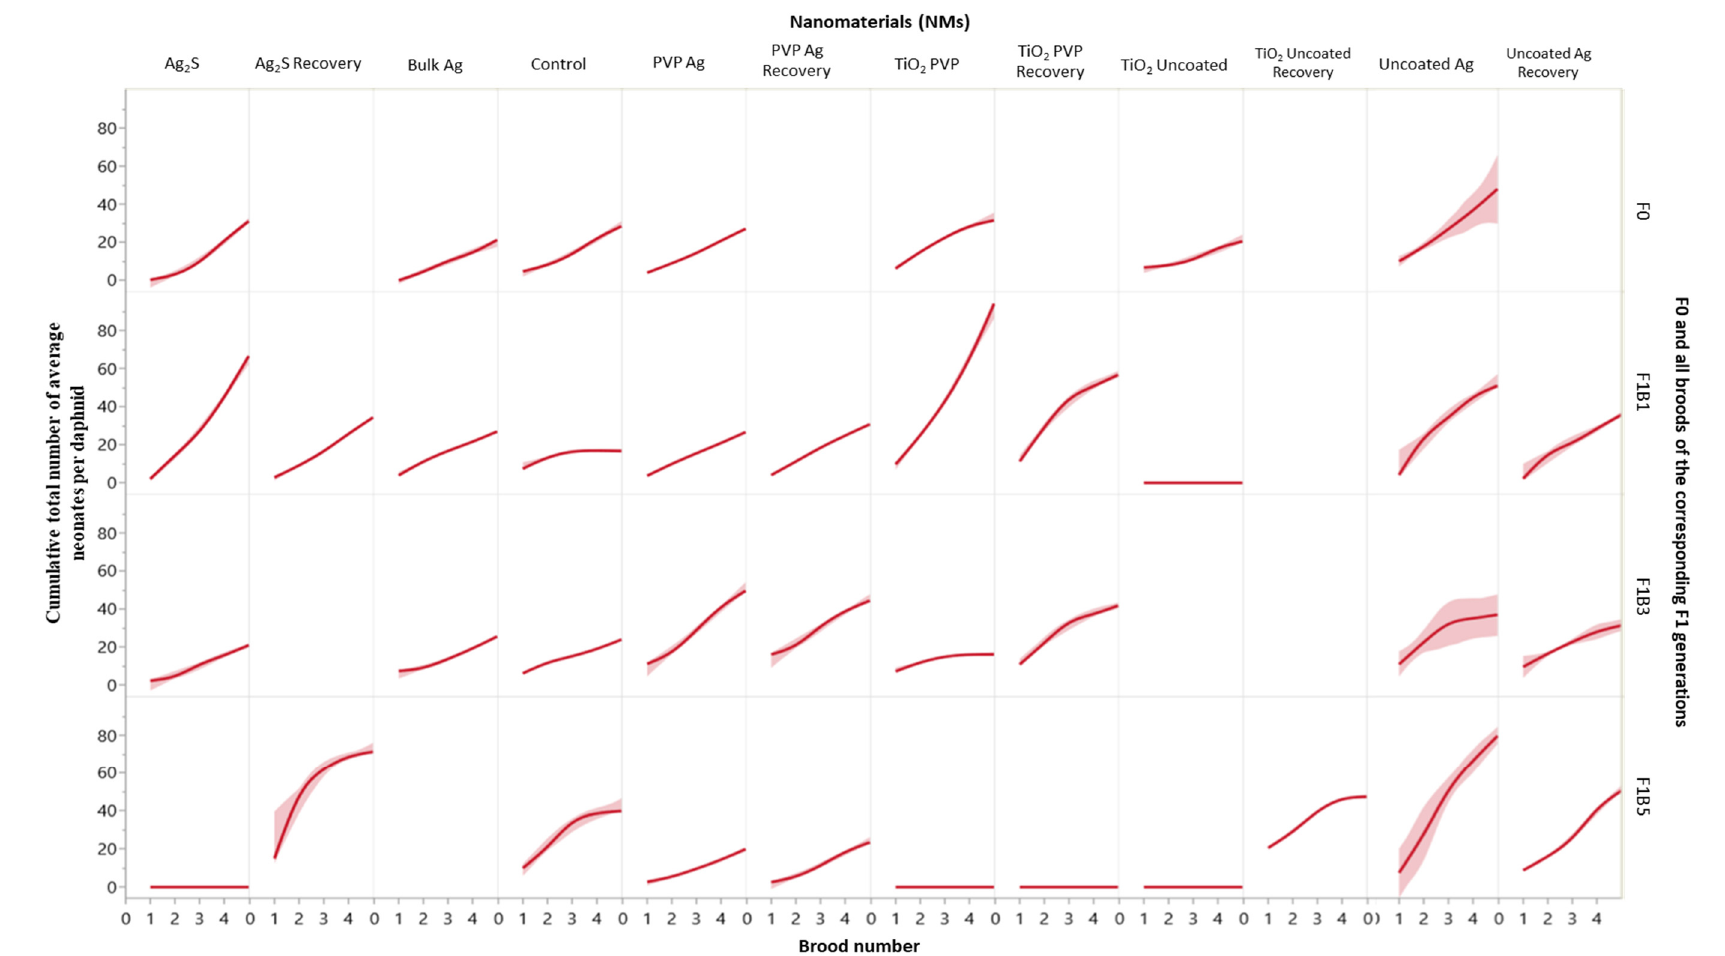
Figure 3. The average cumulative total neonates per daphnid for each brood (1–5), for all F0 generation and broods F1B1, F1B3 and F1B5 of the subsequent F1 generations. Data are presented for daphnids continuously exposed to each of the Ag and TiO 2 NMs, and those in the recovery sets after removal from exposure. The Y -axis indicates the average cumulative total neonates per daphnid with increasing brood number on the X -axis. F0 = Parent exposure to the particular NM is noted at the top of the plots. The graph is split horizontally by each of the generations and vertically by the NM exposure condition. The shaded areas around the lines are the 95% confidence bands.